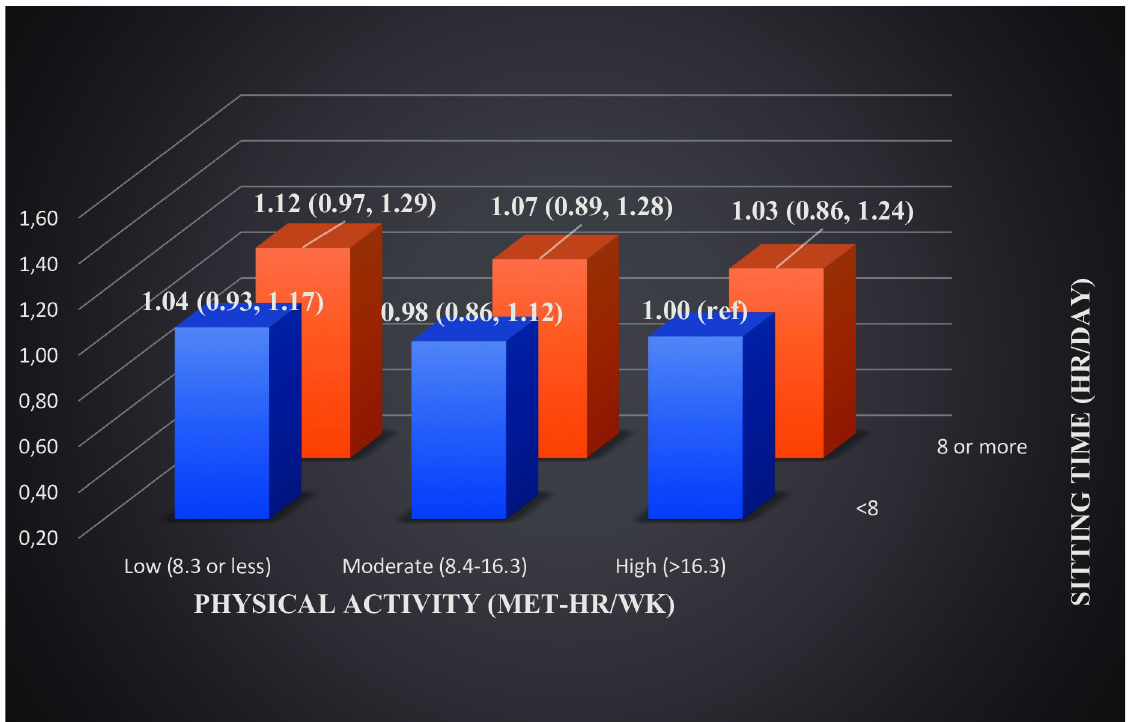
Fig 2. Joint association of sitting time and physical activity with total cancer, adjusted HRs in